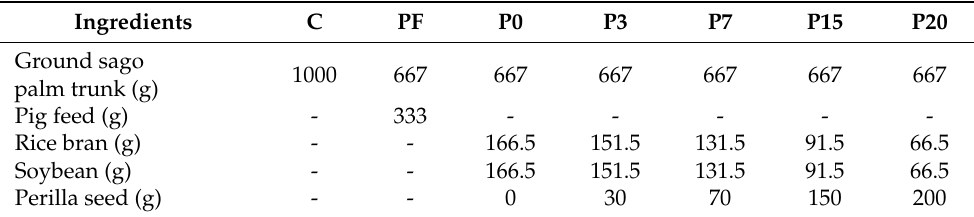
Table 1. Ingredients of experimental